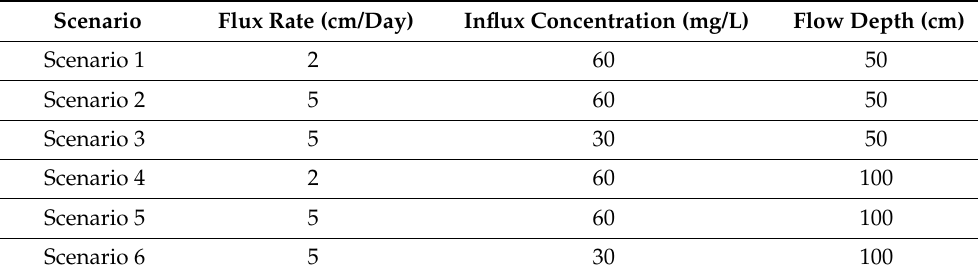
Table 5. Scenario analysis summary.